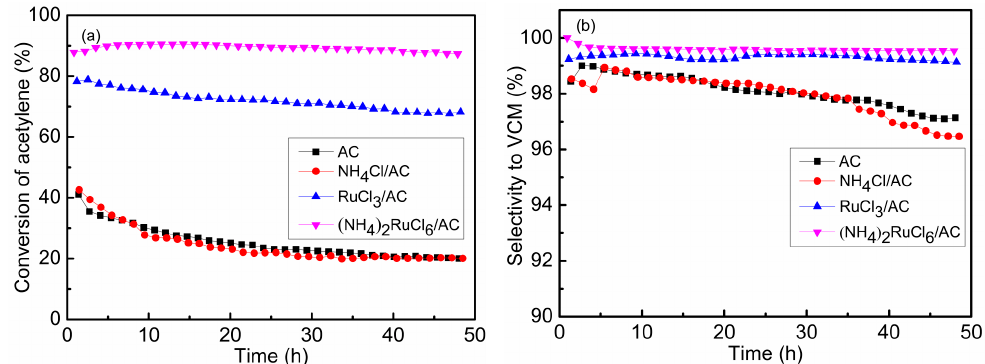
Figure 1. Acetylene conversion ( a ) and selectivity to Vinyl Chloride Monomer (VCM) ( b ) over activated carbon (AC), NH 4 Cl/AC, RuCl 3 /AC, and (NH 4 ) 2 RuCl 6 /AC catalysts. Reaction conditions: T = 170 ◦ C,